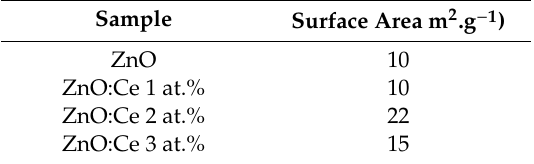
Table 4. Numerical values of the e ff ective rate constant estimated using the LH